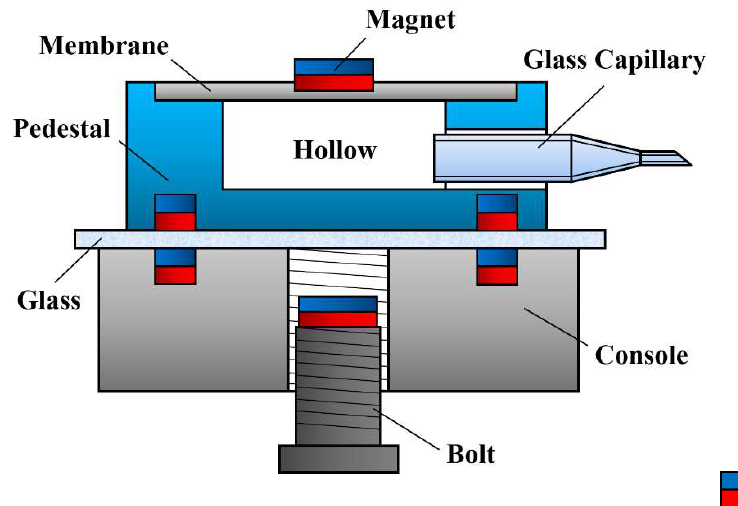
Figure 2. Structure of proposed millirobot.